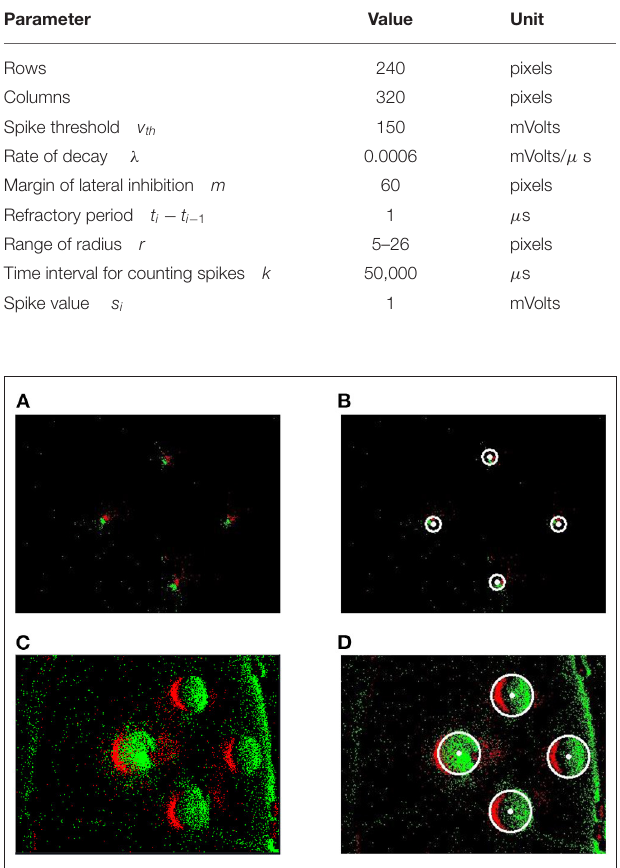
TABLE 2 | The parameters of SNN based asynchronous Hough transform.